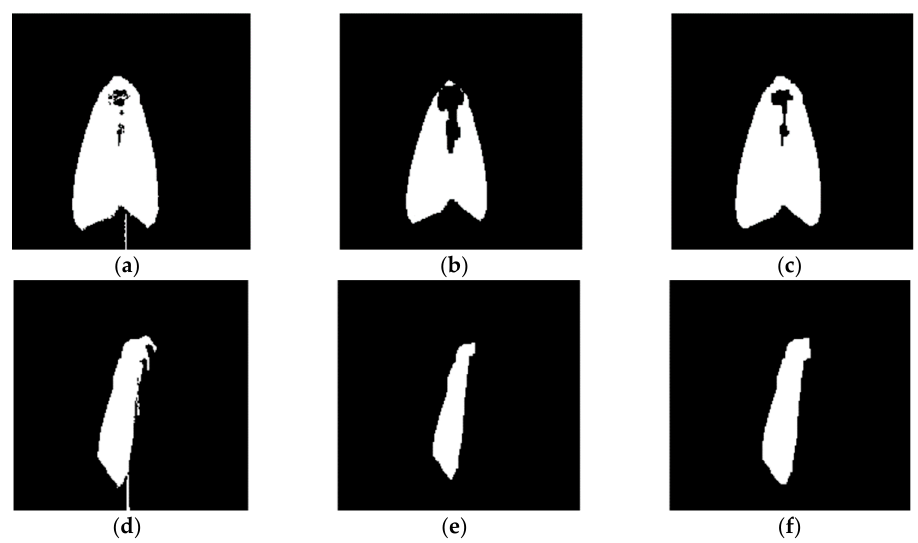
Figure 6. Schematic diagram of erosion and dilation: ( a ) binarization of the back view image; ( b ) erosion after binarization of the back view image; ( c ) dilation after binarization of the back view image; ( d ) binarization of the right view image; ( e ) corrosion after binarization of the right view image; and ( f ) corrosion expansion after binarization of the right view image.